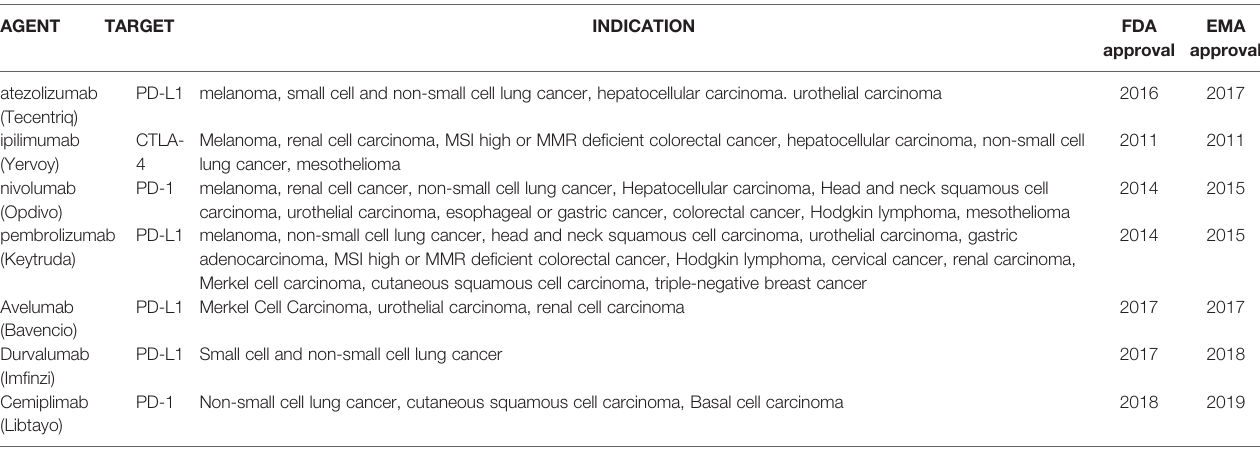
TABLE 1 | Immune checkpoint inhibitors approved by US and European regulatory authorities. AGENT